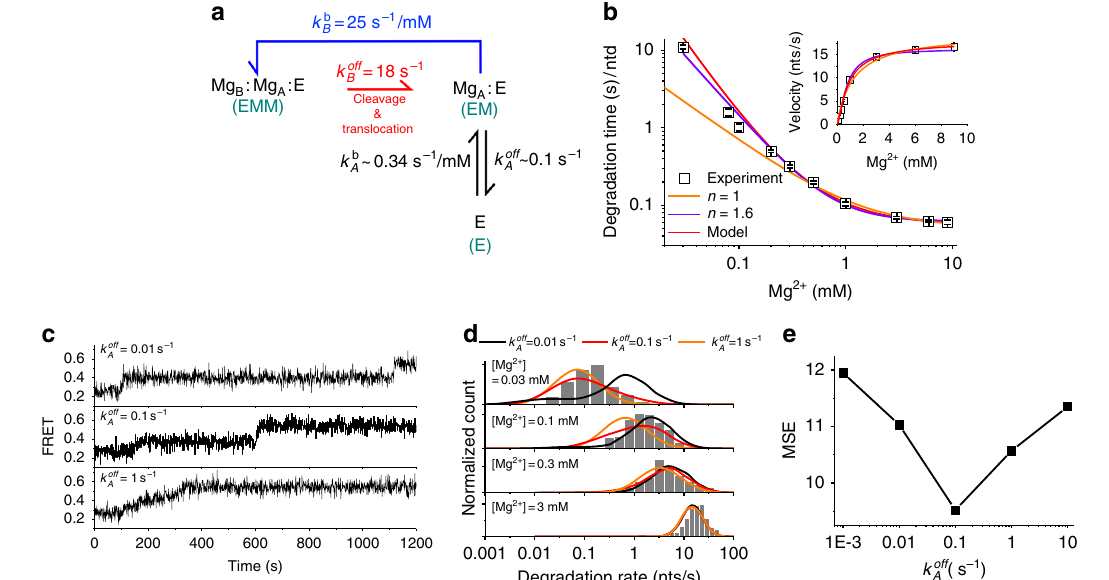
Fig. 4 Quantitative analysis of two-metal dynamics. a A kinetic model for the two-metal-ion dynamics consisting of three states: EMM (exonuclease:Mg B 2 + :Mg 2 + complex), EM (exonuclease:Mg 2 + complex), and E (exonuclease only). In the model, Mg 2 + dissociates upon DNA cleavage and translocation ( A A B k off EMM to EM ) whereas Mg EM to E ). The single cycle is completed upon rebinding of Mg EM to 2 + dissociates stochastically ( k off 2 + ( k b B , A , B , red arrow, A B EMM ). b The degradation time per nucleotide ( τ 2 + concentrations. The data are fi tted to three models: (1) Michaelis Menten equation (orange 1 ) versus Mg line), (2) Hill equation (purple line, n = 1.6), and (3) Eq. 1 for the model shown in a (red line). Inset shows velocity ( = τ (cid:3) 1 ) versus Mg 2 + concentrations 1 data and their fi ts (solid lines). c Representative FRET time traces from simulations performed at three different choices of k off A : 0.01 s − 1 (top panel), 0.1 s − 1 (middle panel), and 1 s − 1 (bottom panel). [Mg 2 + ] is set to 0.03 mM. d Degradation rate histograms at four different [Mg 2 + ] conditions: 0.03 mM, 0.1 mM, 0.3 mM, and 3 mM. Gray bars represent experimental data, whereas solid lines are theoretical prediction calculated under three difference choices of k off A : 0.01 s − 1 (black), 0.1 s − 1 (red), and 1 s − 1 (orange). e Mean squared error (MSE) versus k off A . The errors are calculated by summing the squares of